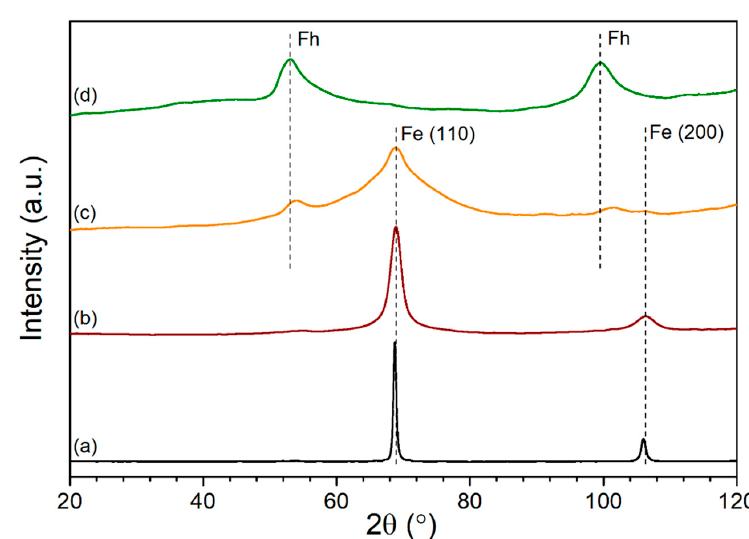
Figure 1. The X-ray diffraction analysis (XRD) patterns of powders obtained by reduction from FeCl 2 ( a ); FeCl 3 ( b ); FeSO 4 ( c ); Fe(NO 3 ) 3 ( d ).